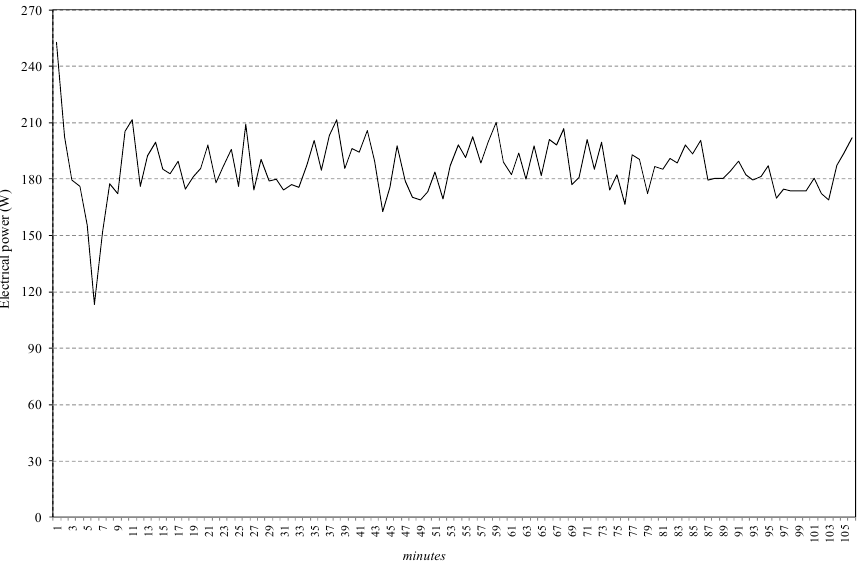
Energies 2018 , 11 , x FOR PEER REVIEW Figure 6. Flow-chart of the experimental and theoretical analysis. Figure 6. Flow-chart of the experimental and theoretical analysis.